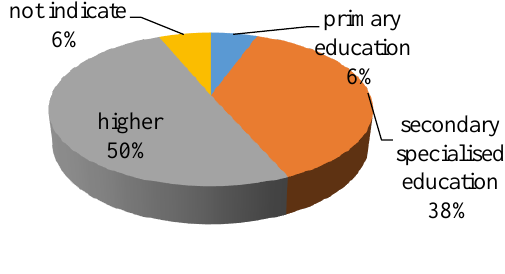
Fig. 2. Respondents’ level of